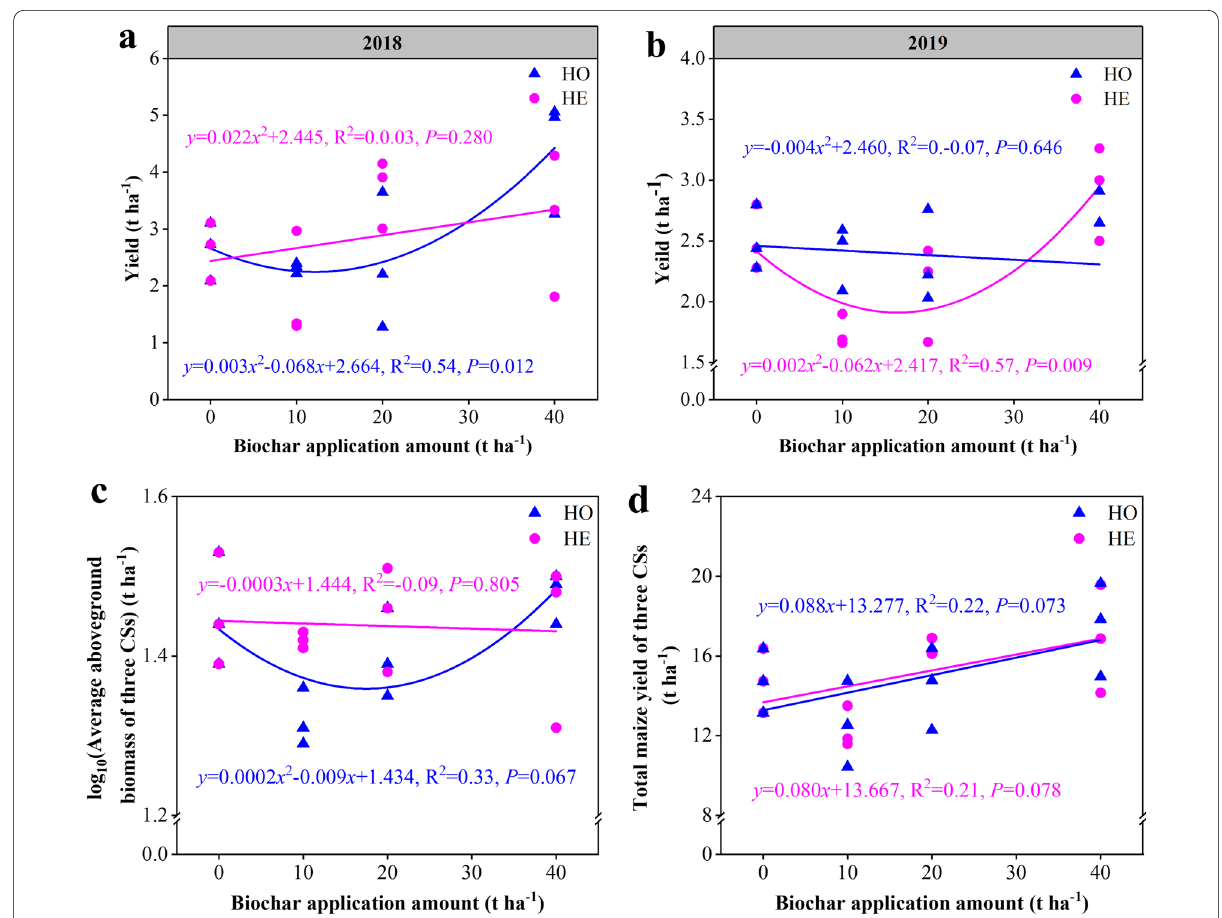
Fig. 7 The relationship between crop productivity index and biochar application amount. a The relationship between yield and biochar application amount in 2018. b The relationship between yield and biochar application amount in 2019. c The relationship between average aboveground biomass and biochar application amount in three CSs (2018–2020). d The relationship between total maize yield and biochar application amount